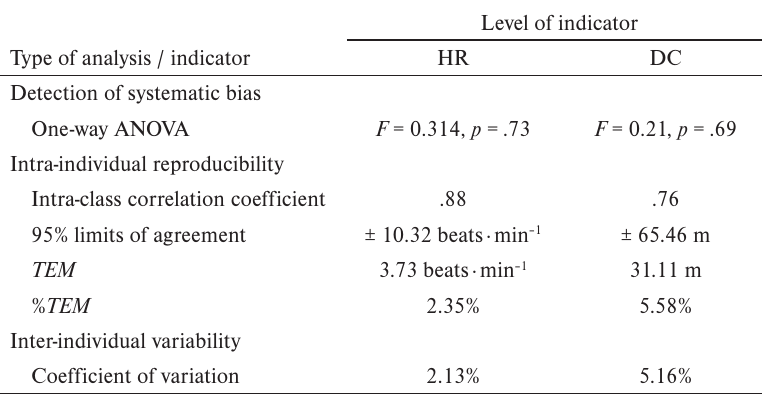
Overview of reliability analysis